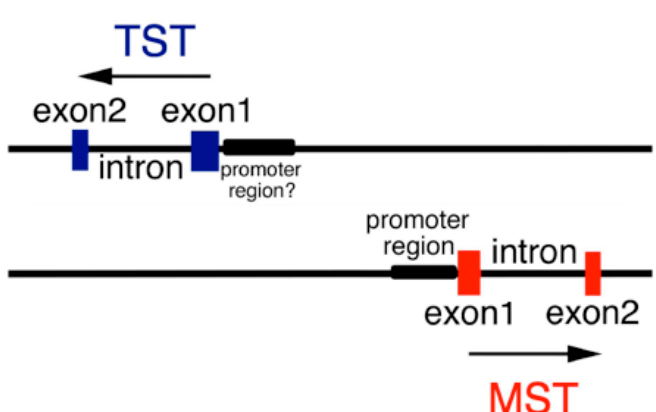
Figure 1. Alignment of TST and MST genes on mouse chromosome 15. Each of two family genes contains two exons and an intron (NC_000081.6). The 5 ′ -Flanking region of the TST gene has not been identified, however, a prompter region exists. Arrows represent transcriptional direction. Details are described in the text.